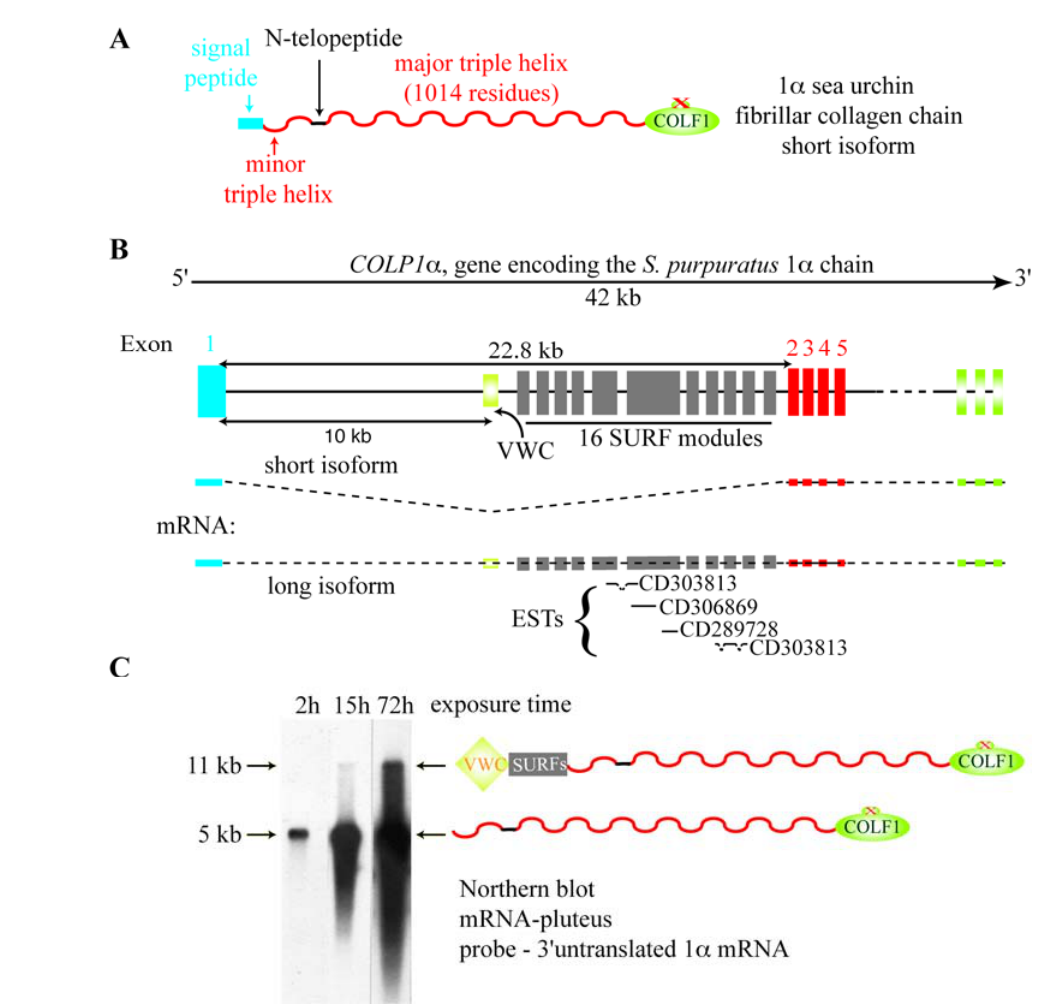
Figure 3. The sea urchin 1  fibrillar collagen chain. ( A ) Modular structure of the 1  chain. Domains are illustrated as in Figure 1. ( B ) the exon/intron structure of COLP 1  , the gene encoding the S. purpuratus 1  chain. The COLP1  sequence is available using a sea urchin server (http://genome.ucsc.edu/cgi-bin/hgGateway; Scaffold69286:454253-495522 bp). Exons are represented by closed boxes. Below the COLP1  gene, the short and putative long mRNA isoforms are schematized. The four ESTs specific to the long 1  mRNA isoform are indicated with their accession number. ( C ) Northern-blot analysis of 1  mRNA. A short-exposure time of this Northern-blot was shown previously [34]. Here, we present different times of autoradiography, from 2 h to 72